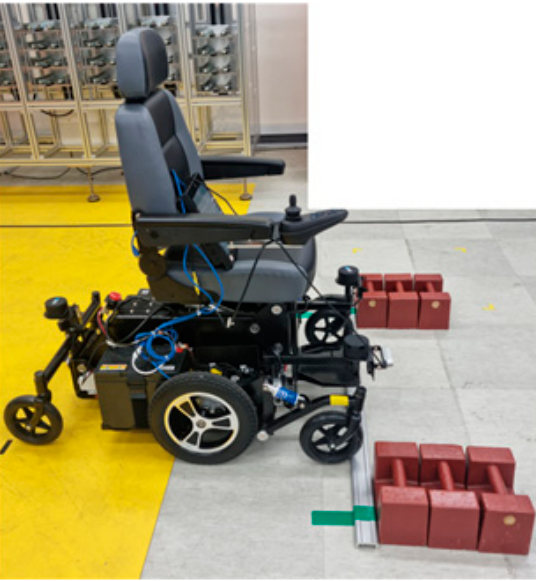
Figure 14. Experiment set-up.